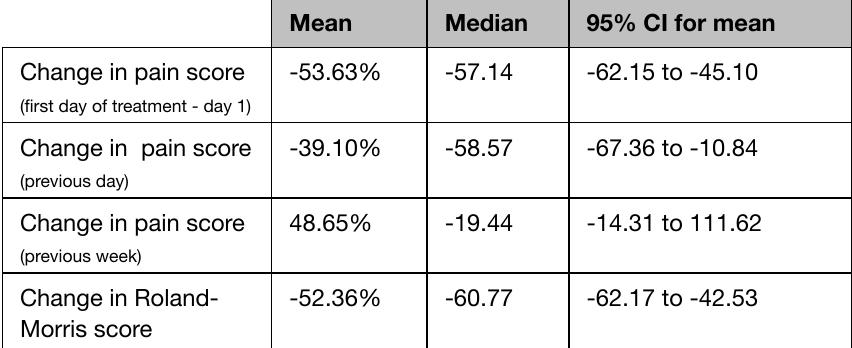
Table 3: Percentage change in pain and disability scores between the